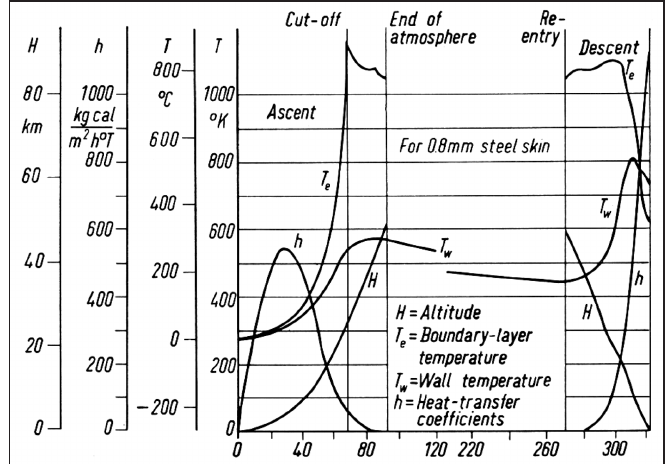
Figure 1: Calculation of wall temperature (Kurzweg, 1957: